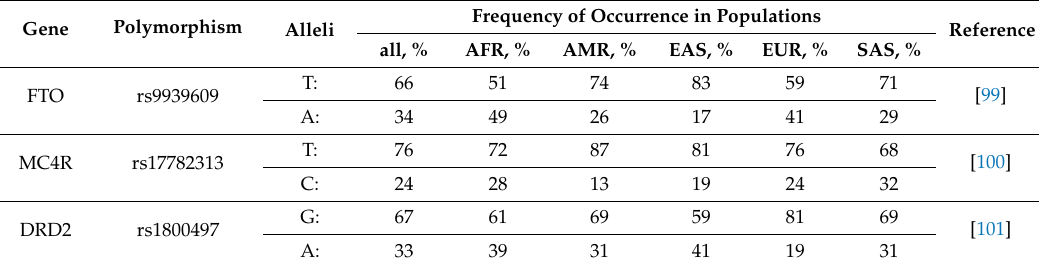
Table 6. Population genetics of genes responsible for eating preferences.